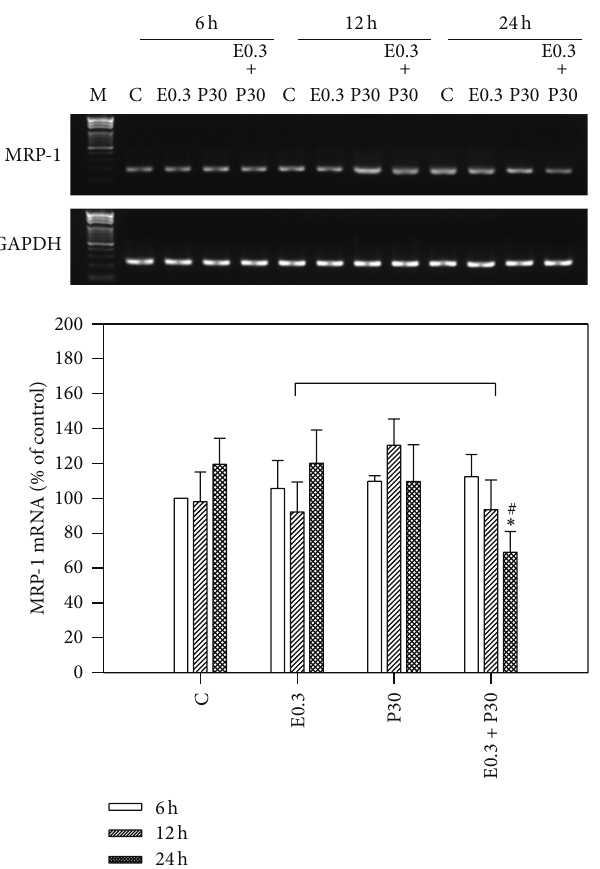
Figure 6: Epirubicin and/or progesterone effect on MRP-1 expres- sion. HA22T/VGH cells were treated with epirubicin and/or pro- gesterone for 6, 12, or 24 h, and then MRP-1 mRNA was analyzed by RT-PCR. The MRP-1 mRNA expression was normalized to GAPDH mRNA. The density of band was expressed as the relative density compared to that in untreated cells (control), taken as 100%. Results are expressed as the mean ± standard deviation (S.D.) for three separate experiments. C: untreated cells, E0.3: 0.3 𝜇 M epirubicin, and P30: 30 𝜇 M progesterone. ∗ 𝑃 < 0.05 compared to the untreated controls. # 𝑃 < 0.05 compared to epirubicin-treated